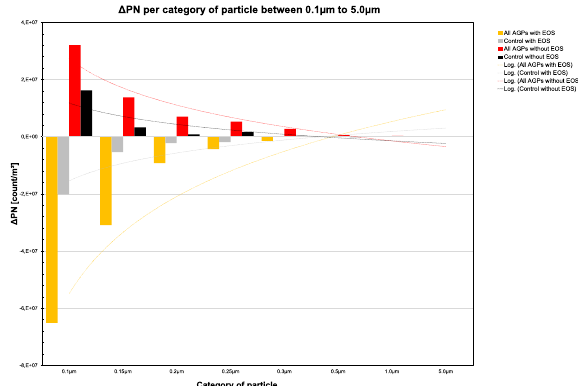
Fig. 2 Illustration of the change in particle number concentration (mean (SD) Δ PN: counts/m 3 ) for eight categories of particles between 0.1 and 5.0 µm for all aerosol-generating procedures (AGP: high-speed rotation handpiece; air polishing with nonabrasive powder; supra-/subgingival scaling with an ultrasonic scaler) and control tests (no AGP) with and without mobile extraoral scavenger (EOS)